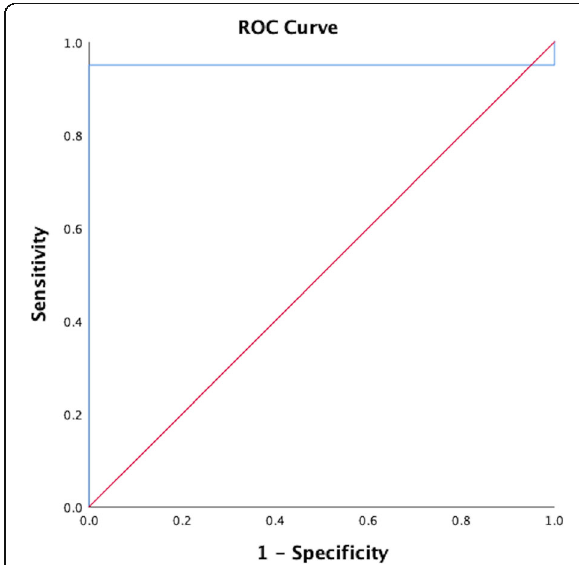
Fig. 4 Receiver operator characteristic analysis of signal intensity in regions of fibrosis in the lower lobes compared to emphysematous areas on the upper lobes in CPFE patients. The area under the curve was 0.95, p < 0.001. Using a SI value of ≥ 12 resulted in a sensitivity of 95% and a specificity of 100% in differentiating fibrosis from emphysema in CPFE. CPFE , Combined pulmonary fibrosis and emphysema